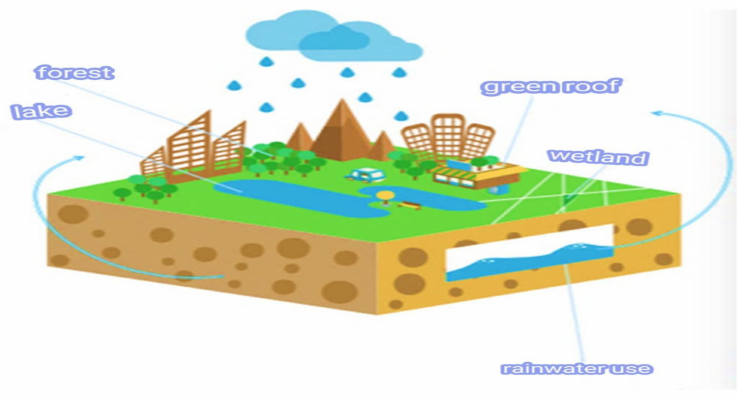
Figure 2. Schematic diagram of urban water